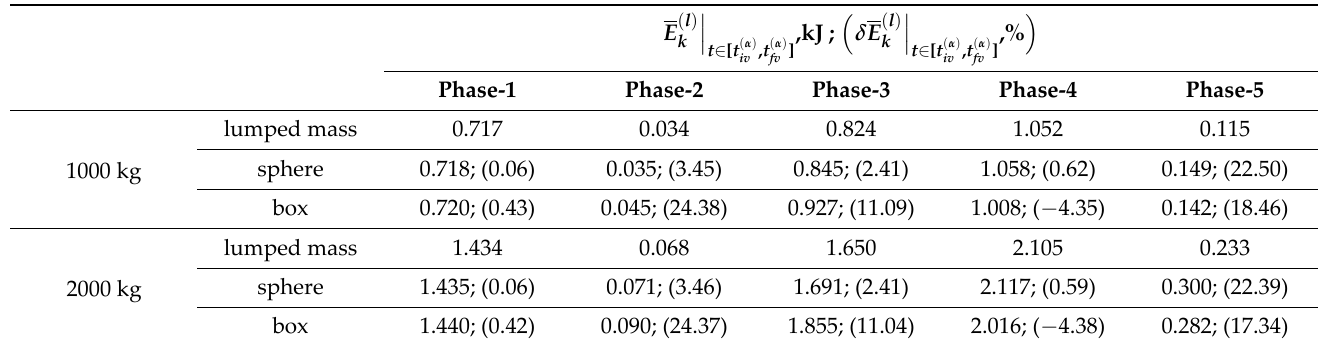
Table 3. The kinetic energy integral mean values in the movement phases and their relative percent‑ age